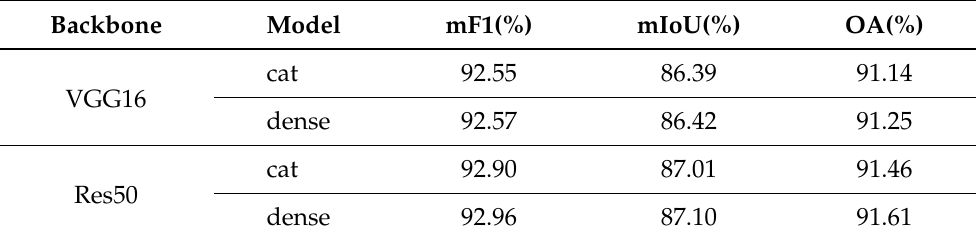
Table 10. Comparison of the methods of concatenation (cat) and dense connection (dense) for Potsdam dataset.